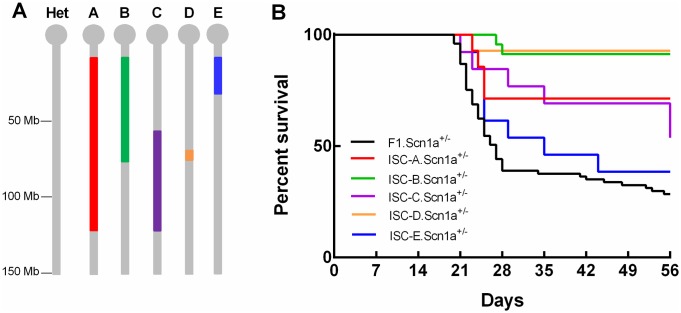
Fine mapping of Dsm1 with ISC strains.A. Dsm1 ISC lines A-E carry varying 129 derived chromosome 5 segments (colors) on a congenic B6 background (grey). B. Survival of resulting F1.KO offspring was monitored to 8 weeks of age. Kaplan Meier survival plot is shown. Survival was significantly improved in mice with homozygous 129/129 alleles in ISC-A (p<0.01), ISC-B (p<0.0001), ISC-C (p<0.05), and ISC-D (p < 0.0002) compared to F1.KO heterozygous controls. P values were determined by LogRank Mantel-Cox test.